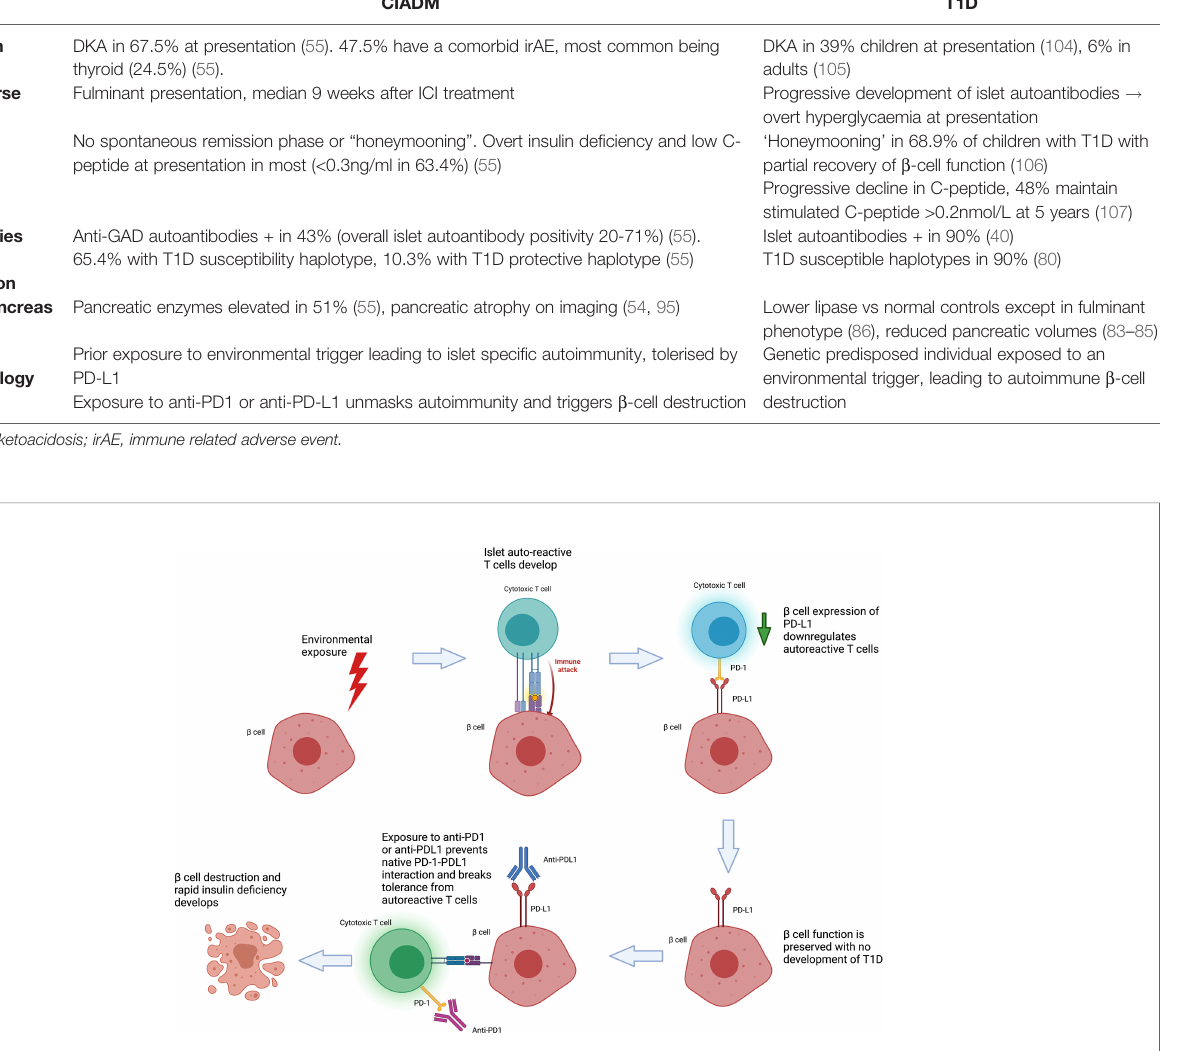
FIGURE 2 | Proposed Pathogenesis of Checkpoint Inhibitor Associated Autoimmune Diabetes